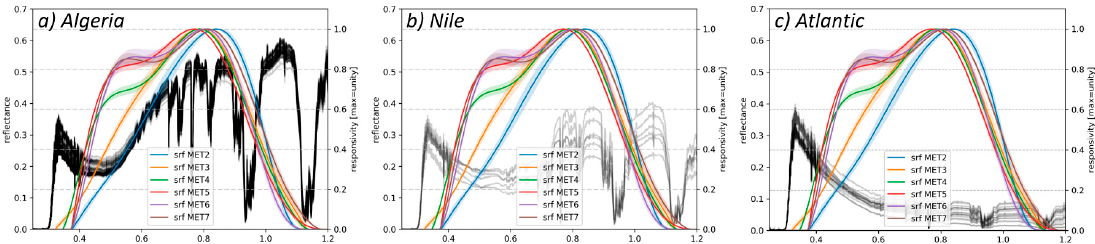
Figure 2. Spectral Response functions of Meteosat-2-7 plotted together with SCanning Imaging Absorption spectroMeter for Atmospheric CartograpHY (SCIAMACHY) spectra acquired during 2002 at three target sites. ( a ) shows the spectra measured by SCIAMACHY at the Algeria site, ( b ) shows the spectra measured at the Nile-delta and the ( c ) shows those measured at the Atlantic-1 site. Spectra are plotted at in transparent black to better illustrate their spread. Spectra with strong cloud contamination were removed before plotting (see Section 3.9.1). Note that for band-adjustment / homogenisation more sophisticated filtering regarding clouds and scene heterogeneity is applied (Section 3.9.1).